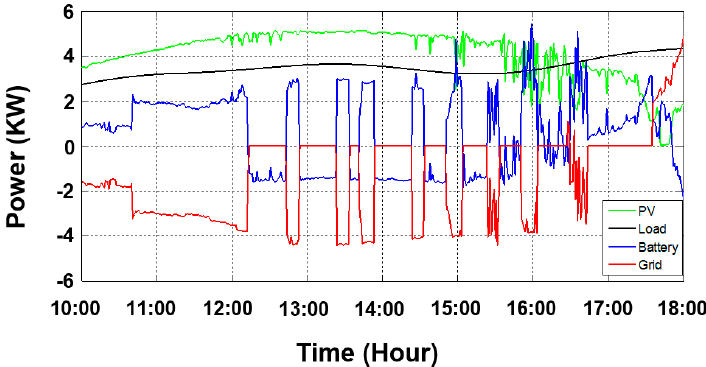
Figure 17. Fuzzy-based EMS in sunny day: power management of the hybrid system.